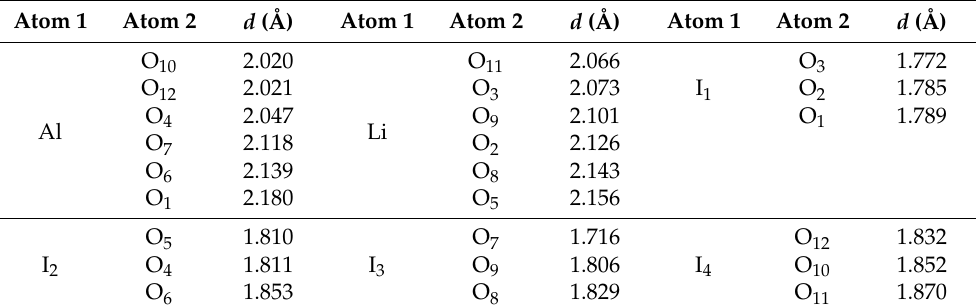
Table 2. Interatomic bond distances d in the coordination polyhedra of LiAl(IO 3 ) 4